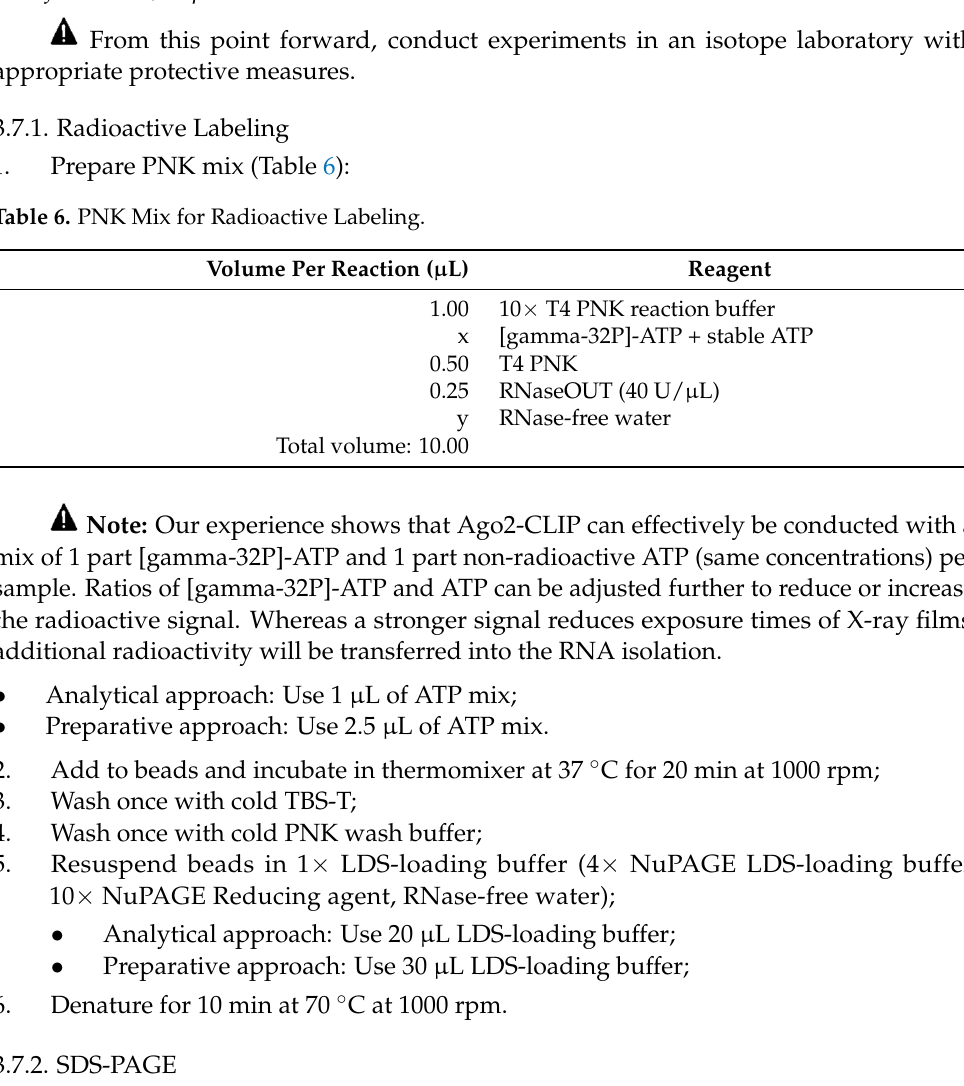
Run PCR (Table 11): Table 11. PCR Scheme for Preamplification of cDNA. Step